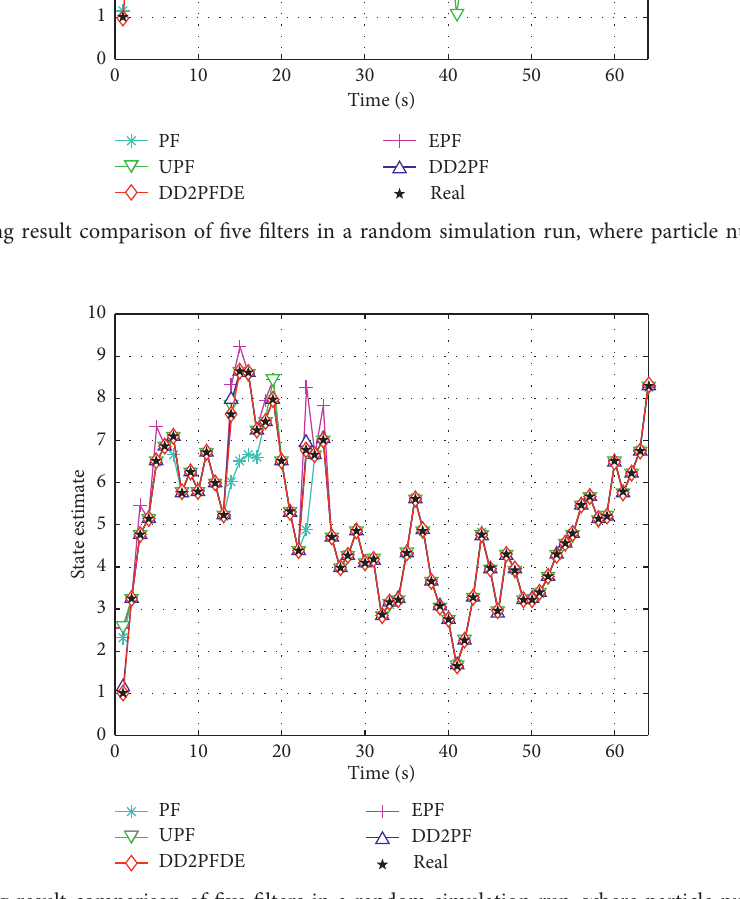
Figure 3: Filtering result comparison of five filters in a random simulation run, where particle numbers N �